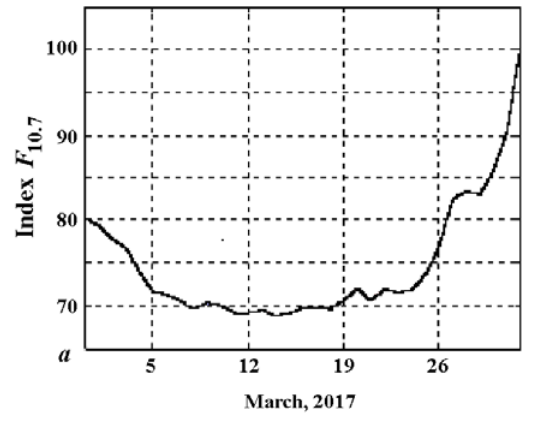
Fig. 3. F 10.7 index (solar radiation flux at the wavelength of 10.7 cm, in units ×10 22 W/(m 2 ·Hz).